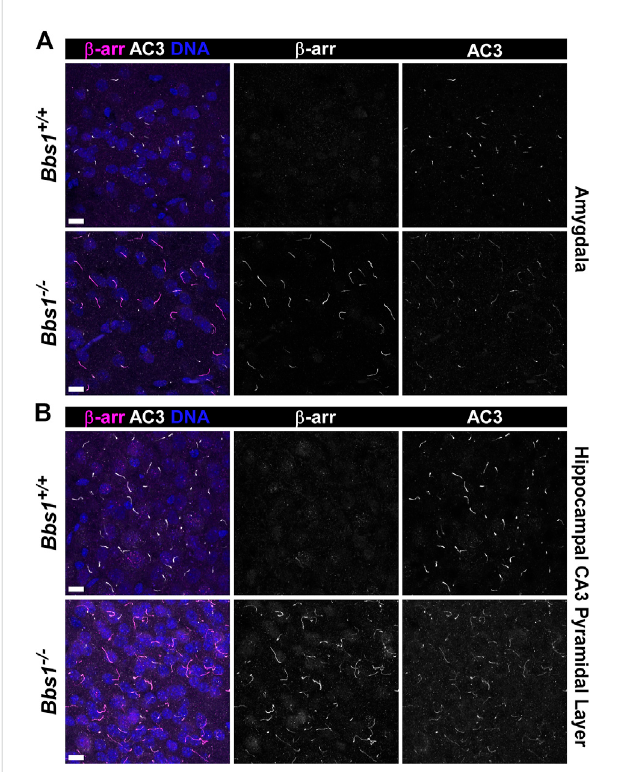
FIGURE 6 β -arrestin accumulates in cilia in the brains of Bbs1 − / − mice (A) Representative images of the amygdala from adult Bbs1 +/+ (upper row) and Bbs1 − / − (lower row) mice colabeled for β -arrestin ( β -arr; magenta) and AC3 (white). β -arrestin localized to 0% of AC3-positive cilia in Bbs1 +/+ sections (0/1,540; n = 3 animals) and 90% of AC3-positive cilia in Bbs1 − / − sections (712/790; n = 3 animals) (B) Representative images of the CA3 region of the hippocampus from adult Bbs1 +/+ (upper row) and Bbs1 − / − (lower row) mice colabeled for β -arrestin (magenta) and AC3 (white). β -arrestin localized to 0% of AC3-positive cilia in Bbs1 +/+ sections(0/871; n =3animals)and84%ofAC3-positivecilia in Bbs1 − / − sections (604/722; n = 3 animals). Nuclei are stained with DRAQ5 (blue). Scale bars represent 10